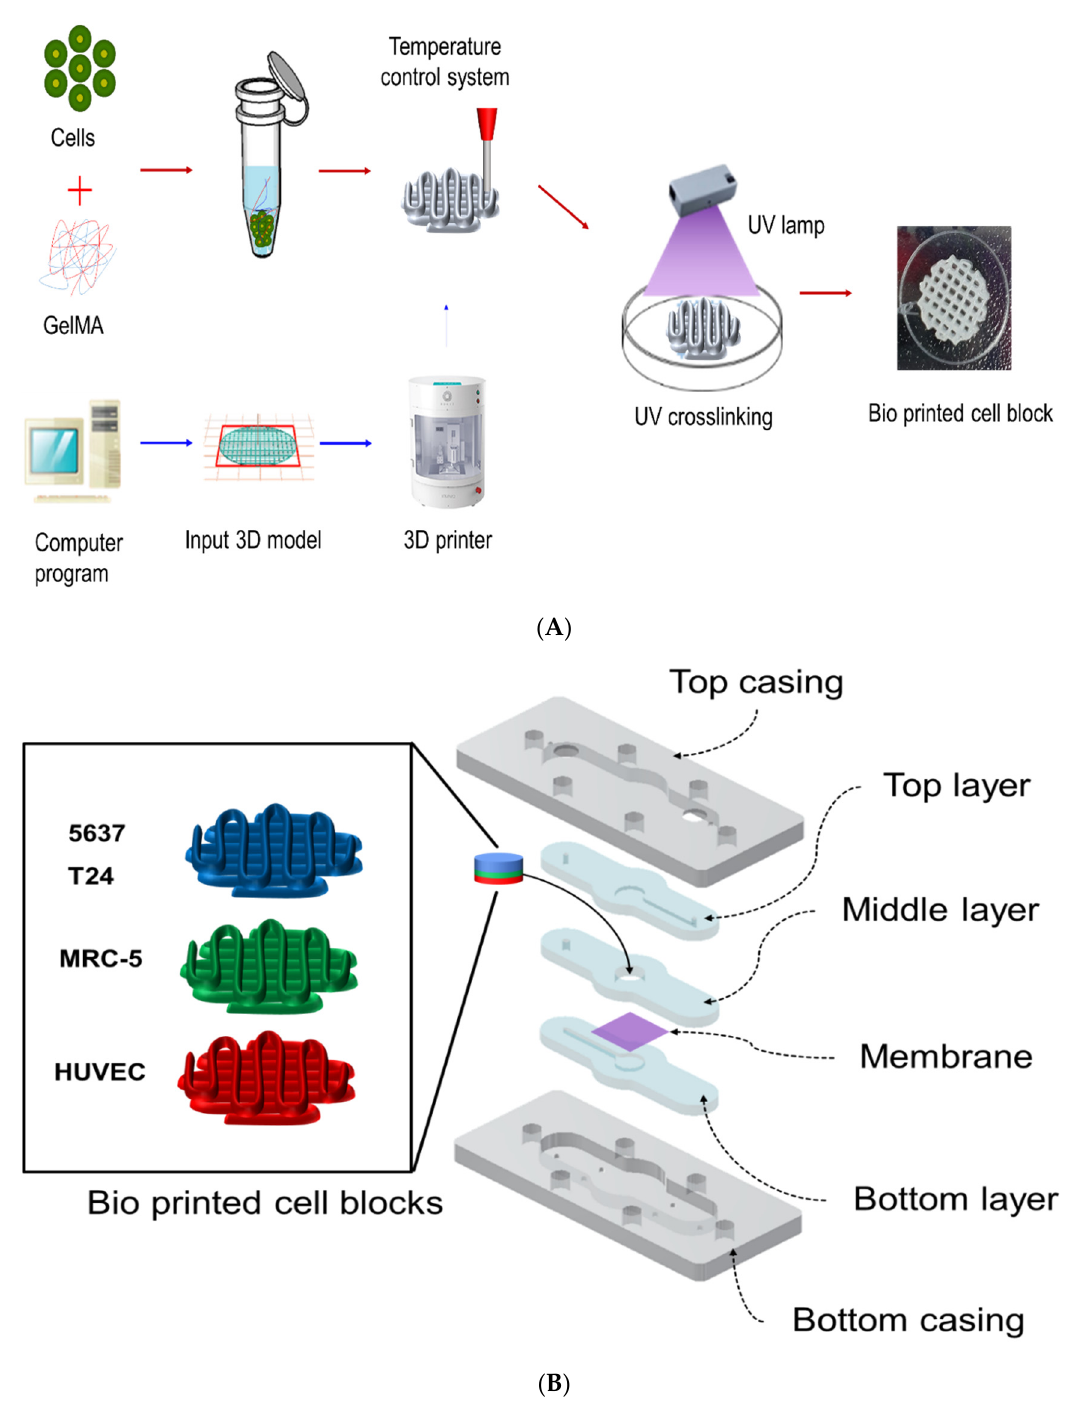
cell block. The height and width of each micro channel are both 1 mm, and the diameter and height of the chamber are 6 mm and 3 mm, respectively (Figure S11).